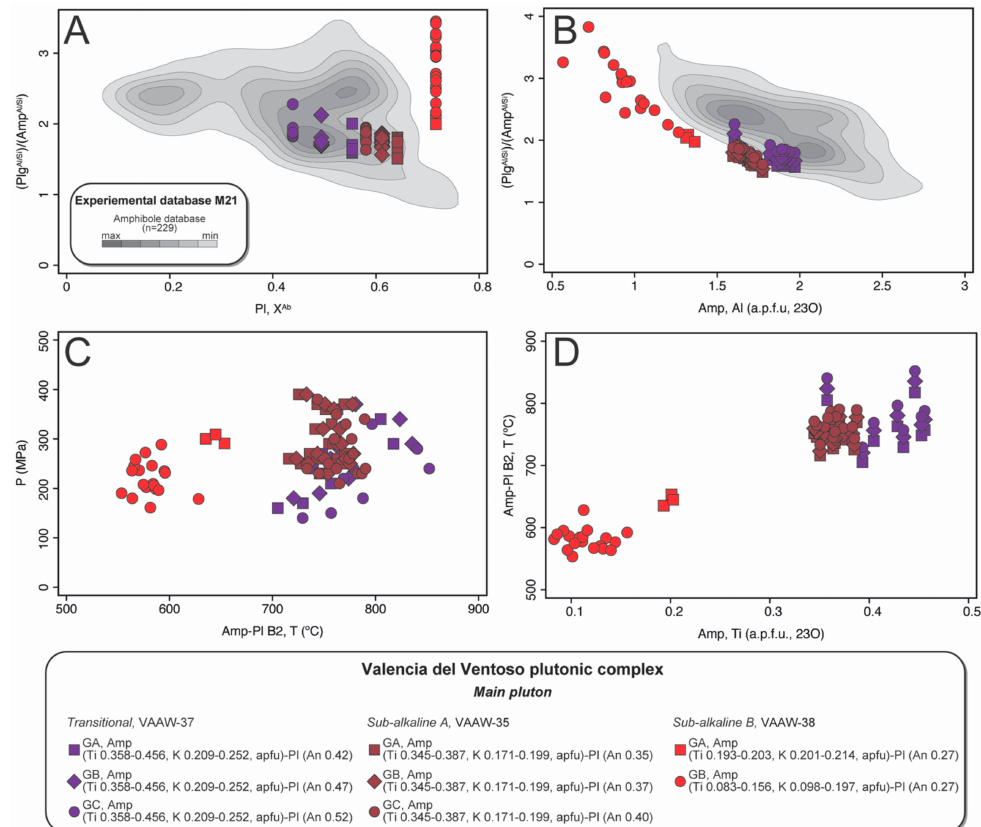
Figure 5. Thermobarometric estimations in intermediate and border facies rocks from the Valencia del Ventoso main pluton. ( A , B ) Al/Si partitioning between plagioclase and amphibole versus albite component in plagioclase and Al occupancy in amphibole from the selected amphibole-plagioclase compositional pairs, also shown bivariate kernel density estimations after [51] of compositional data of synthetic amphibole compiled by [16]; ( C ) P-T estimations for the selected amphibole-plagioclase compositional pairs using expressions by [15,16] for samples VAAW-37 and VAAW-35 and by [16,17] for sample VAAW-38; ( D ) temperature estimates (expression B2 from [16]) versus Ti occupancy in